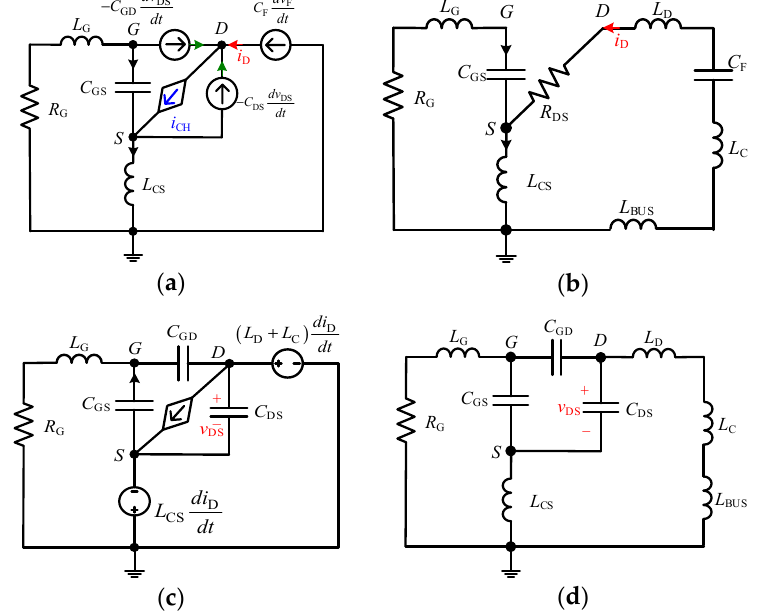
Figure 3. Equivalent circuit of ( a ) Stage 3, ( b ) Stage 4, ( c ) Stage 8, ( d ) Stage 9.